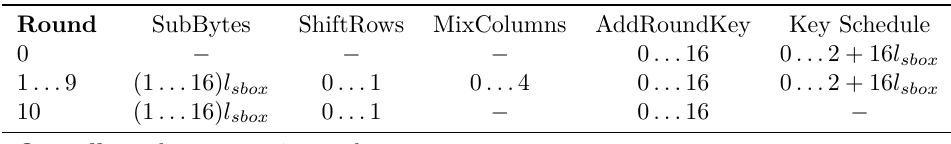
Table 3: Cycle count estimation for full AES-128 hardware implementations with a variable numbers of cycles for the S-box ( l sbox